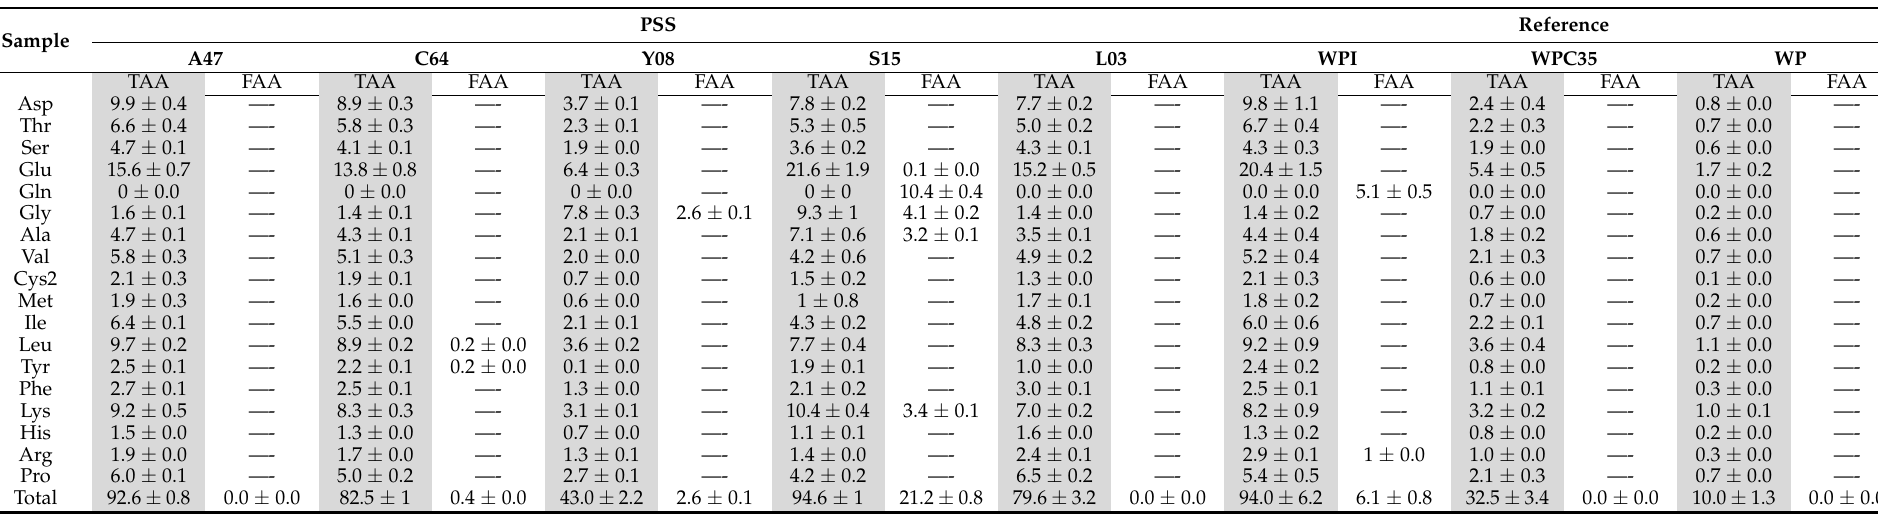
Table 2. Content of total (TAA) and free (FAA) amino acids (g/100 g product) of commercial powdered sport supplements (PSS) and reference samples (REF). Data are the mean ± StdDev of duplicate analyses of n = 3 batches for each commercial PSS and of n = 4 batches of reference